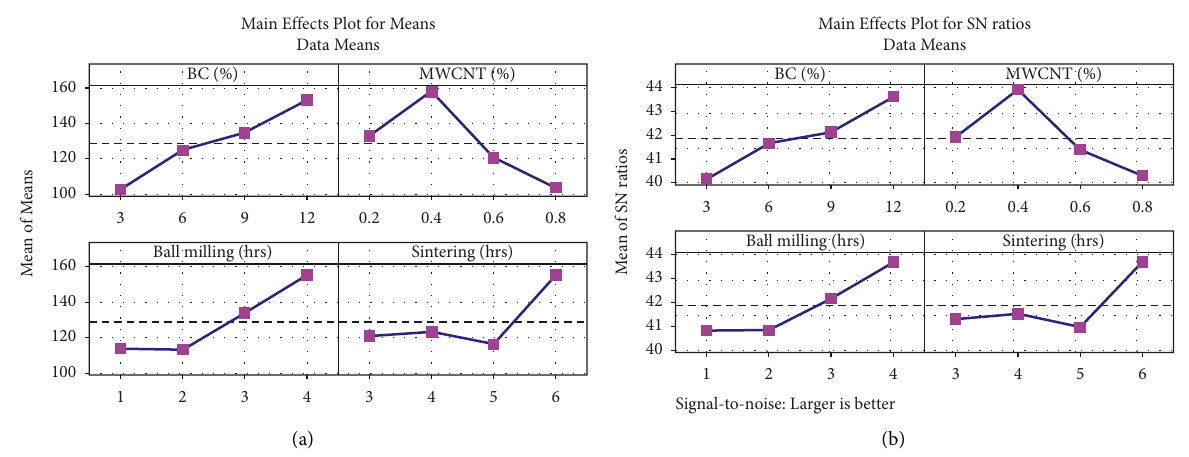
Figure 9: Main effects plot for microhardness analysis: (a) means (b) S/N ratio.